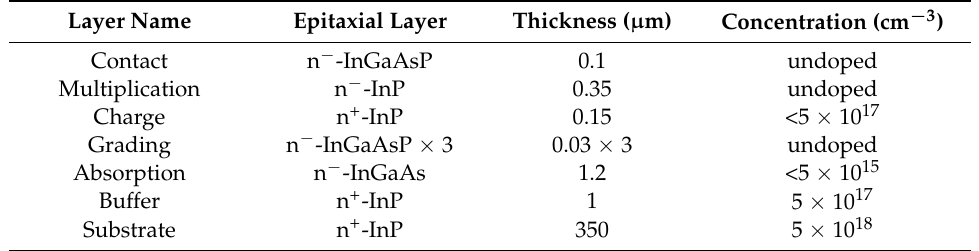
Figure 3. Dark current, photocurrent, and multiplication gain of conventional APD diodes as a function of reverse bias voltage.